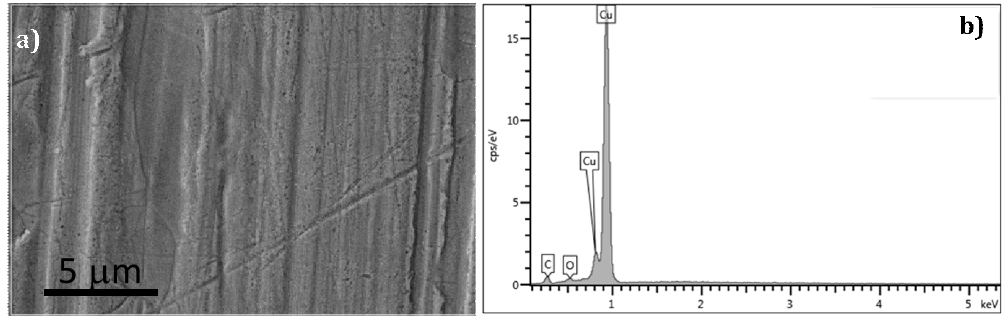
Figure 4. ( a ) SEM secondary electron micrograph of sample 0, with ( b ) qualitative spectra of the area correspondent to ( a ). Table 4. EDS chemical composition of the as-received copper samples.